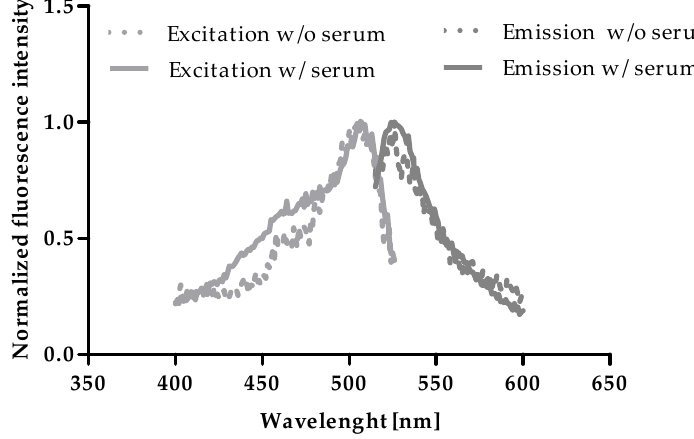
Figure 1. Excitation and emission of Zn 2 + -saturated Zinpyr-1 in the presence and absence of human serum. Excitation (400–526 nm) and emission (515–600 nm) spectra were acquired from Zinpyr-1 [0.05 µM] in the presence of ZnSO 4 [10 mM] in assay-buffer with and without addition of 2% (v/v) of HS.